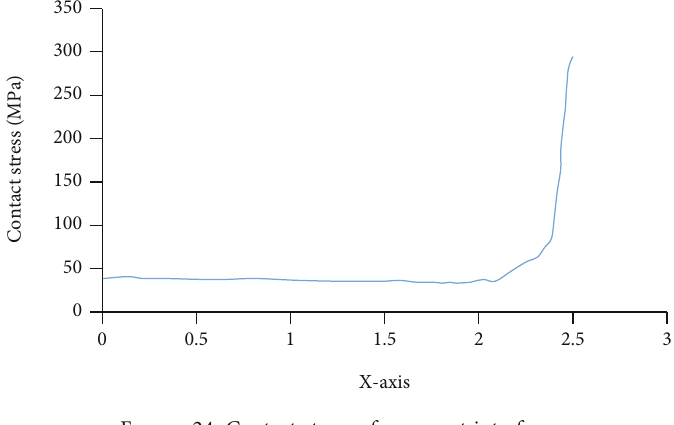
Figure 24: Contact stress of proppant interface. Table 4: Detailed parameters of numerical simulation calculation of high-conductivity channel fracturing. Factors Value Diameter of proppant column (m) — Height of proppant column (mm) — Crustal stress (MPa) — Elastic modulus of the formation